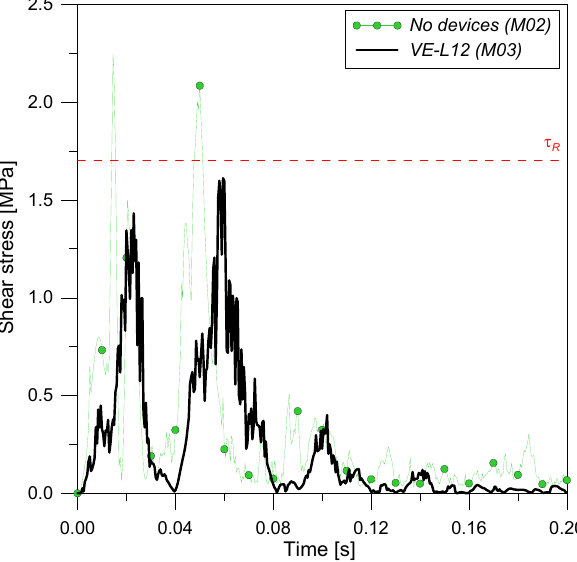
Figure 17. Comparison of maximum envelope of shear stress in the bead of